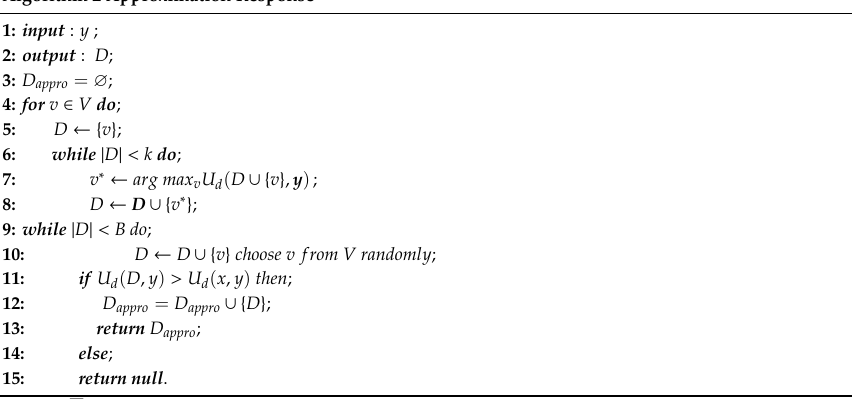
Algorithm 2 Approximation Response